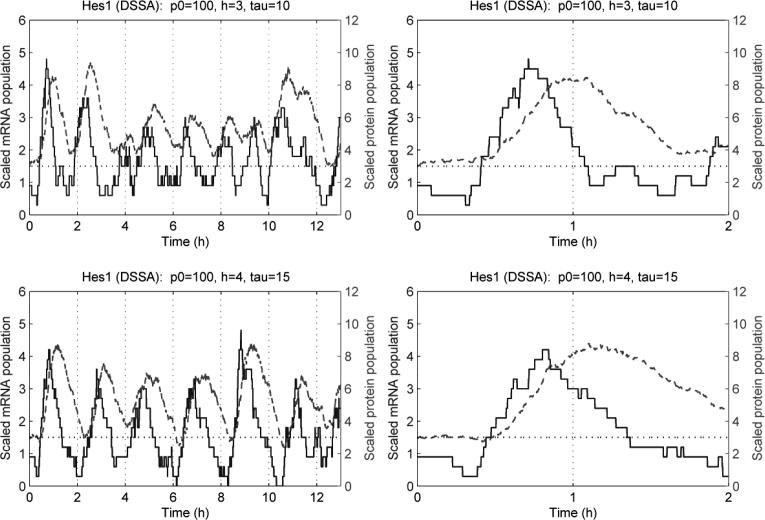
DSSA Simulations for P
0 = 100, h = 3, τ = 10 (Top) and P
0 = 100, h = 4, τ = 15 (Bottom) over 12 h and 2 hLeft, more than 12 h. Right, more than 2 h. The dotted horizontal line corresponds to P
0. Solid lines represent mRNA, dashed lines protein populations.